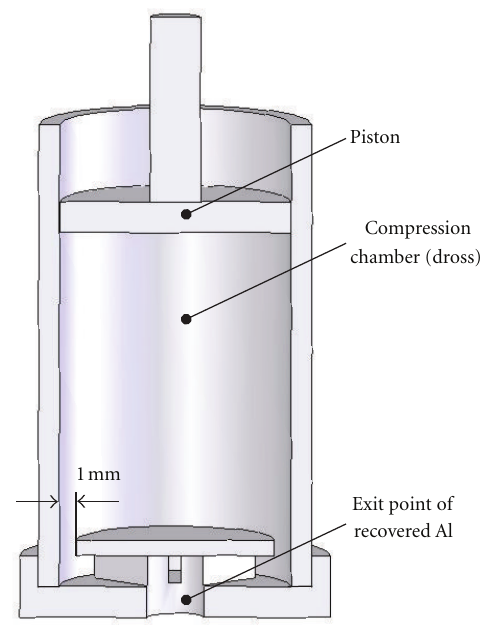
Figure 2: Cylinder used during Al